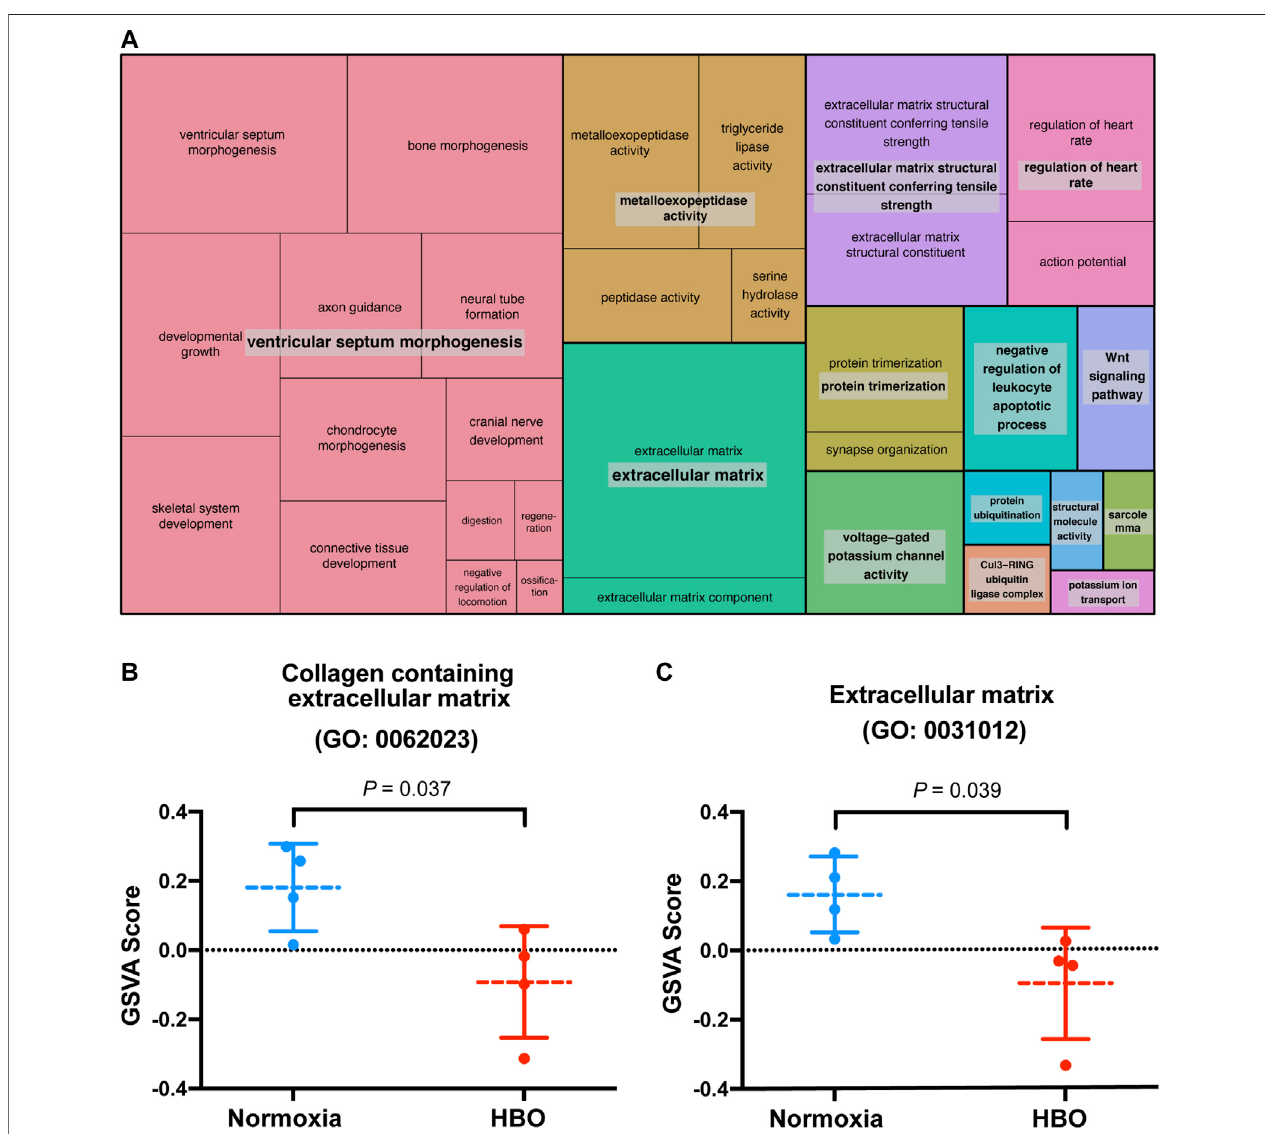
FIGURE 1 | Repetitive HBO treatments downregulate extracellular matrix gene expression in mouse lungs. (A) REVIGO TreeMap showing Gene Ontology (GO) analysisofdownregulated differentially expressed genes(DEGs) inmice lungs exposed torepetitive HBO(GSE143348). Common colorsrepresentgroupingsbased on parent GO terms, and each rectangle is proportional to the relative enrichment of the GO term compared to the whole genome. Genes with a false discovery rate (FDR) < 0.05 were considered as DEGs. (B,C) Graphs showing GSVA scores calculated based on gene lists from GO: 0062023 (collagen containing the extracellular matrix) (B) or GO:0031012 (extracellular matrix) (C) in HBO-treated and control lungs. Data were analyzed with the unpaired t -test. Data are mean ± s.d., with p values indicated. n (cid:2) 4 samples per